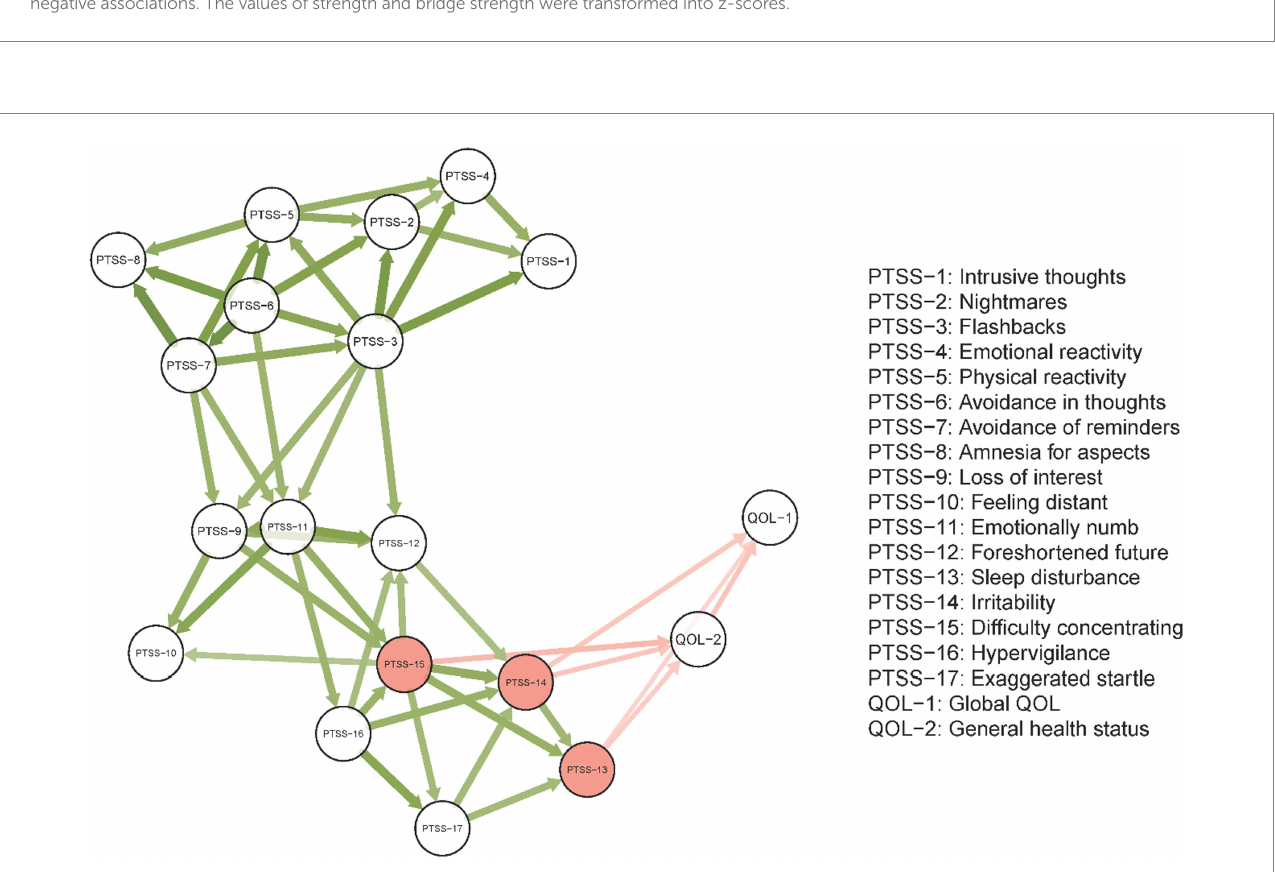
FIGURE 2 Bridge symptoms between the PCL-C and QOL items in the whole sample (N = 10,516). Green edges indicate positive associations; red edges indicate negative associations. The values of strength and bridge strength were transformed into z-scores.